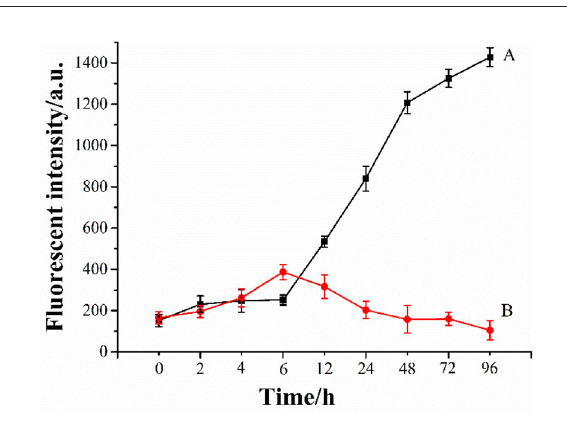
FIGURE6 ThT fluorescence intensity of A β (1–42) (80 µ mol/L) (A) and A β (1–42) (80 µ mol/L)/Ma-3-gal-Cl (10 µ mol/L) (B) mixture at different